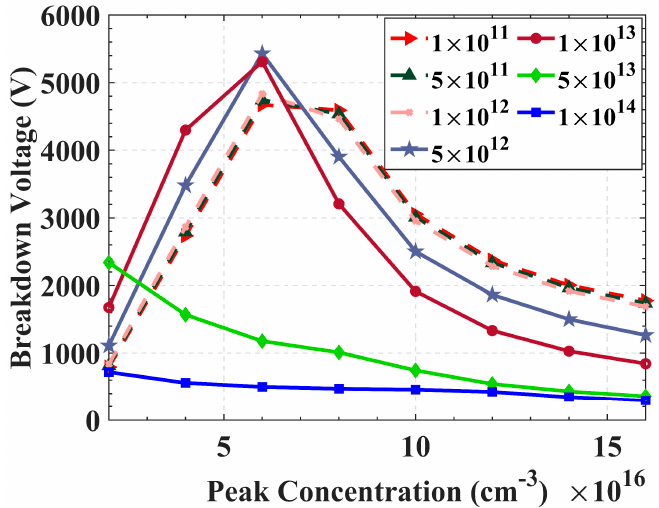
Figure 7. The relationship between peak concentration of floating rings and breakdown voltage at different effective doping concentrations ( N eff ).